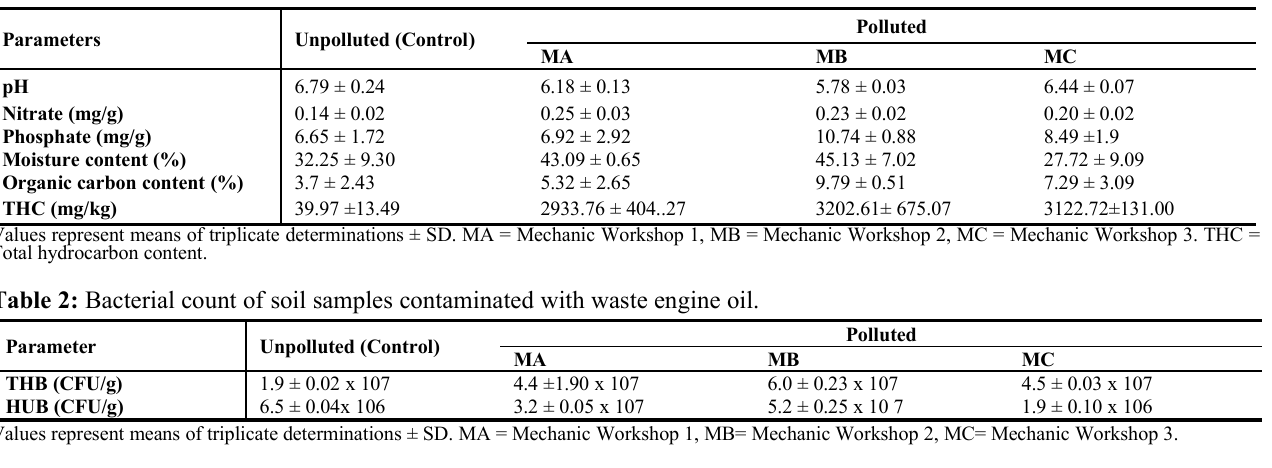
Table 1: Physicochemical properties of different soil samples contaminated with waste engine oil.